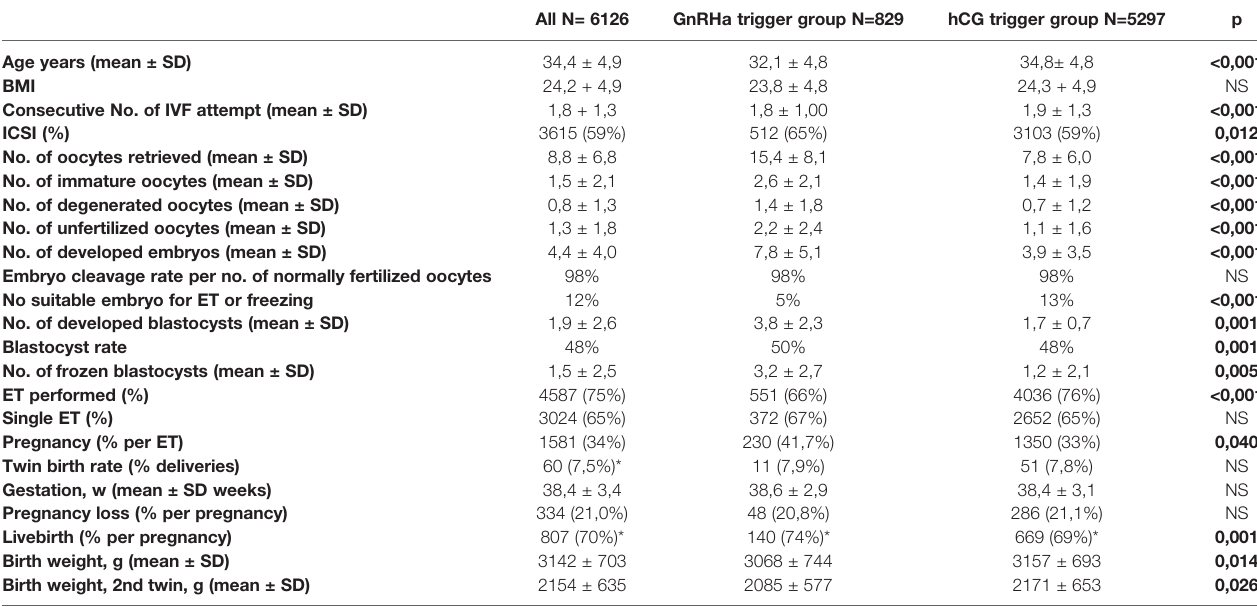
TABLE 1 | Demographic data and IVF-ICSI outcome for women in the GnRHa versus hCG trigger